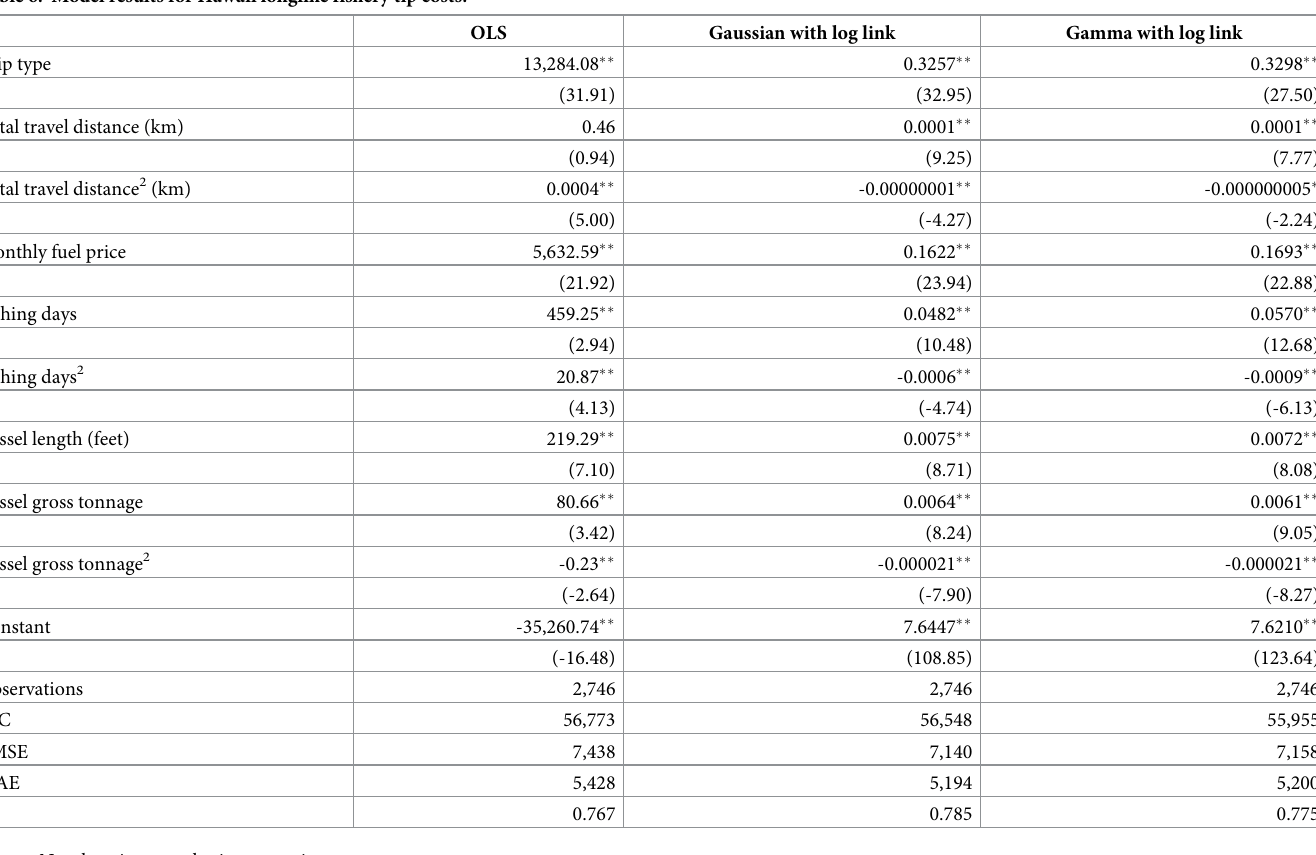
Table 6. Model results for Hawaii longline fishery tip